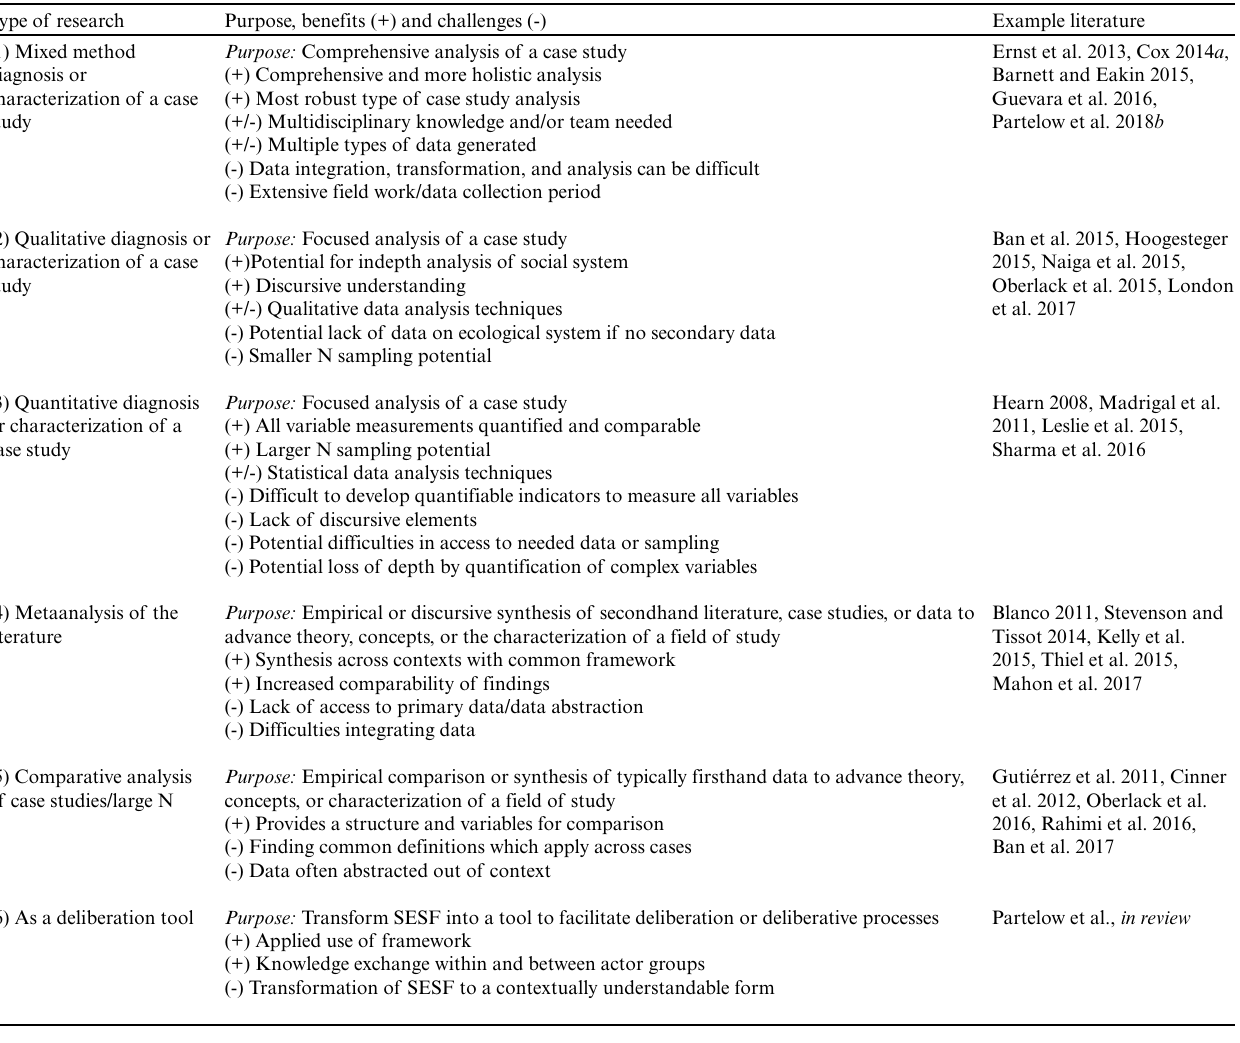
Table 6. Approaches for applying the social-ecological systems framework for different types of research Type of